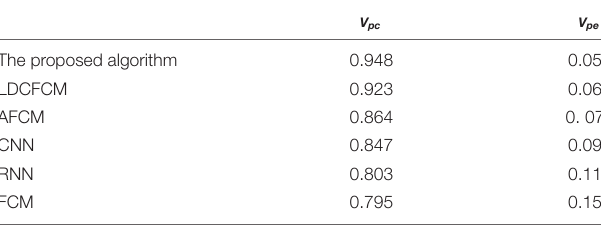
TABLE 1 | Changes in evaluation functions of different models (%).